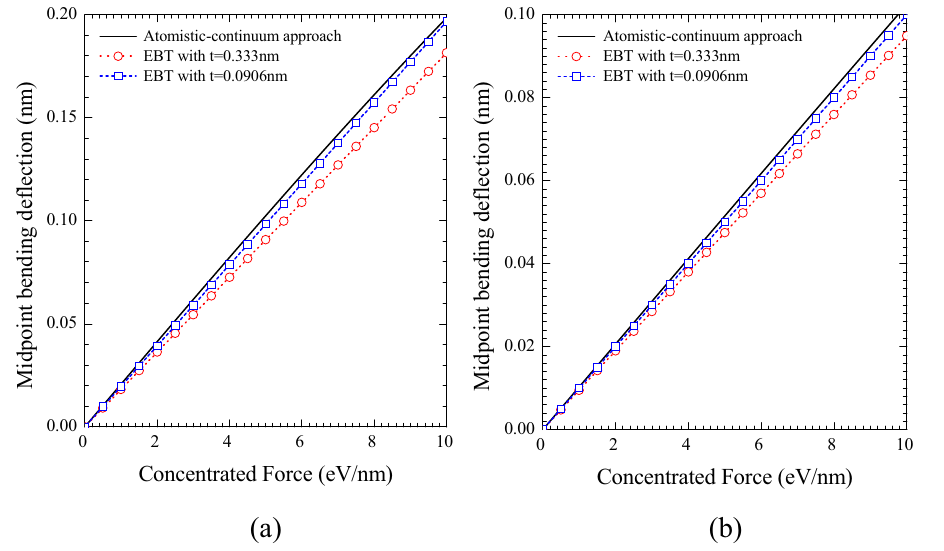
Figure 2: The midpoint bending de fl ection of 10 nm long ( 8, 8 ) ( a ) and ( 10, 10 ) ( b ) BNNTs with simply supported constraint versus external transverse